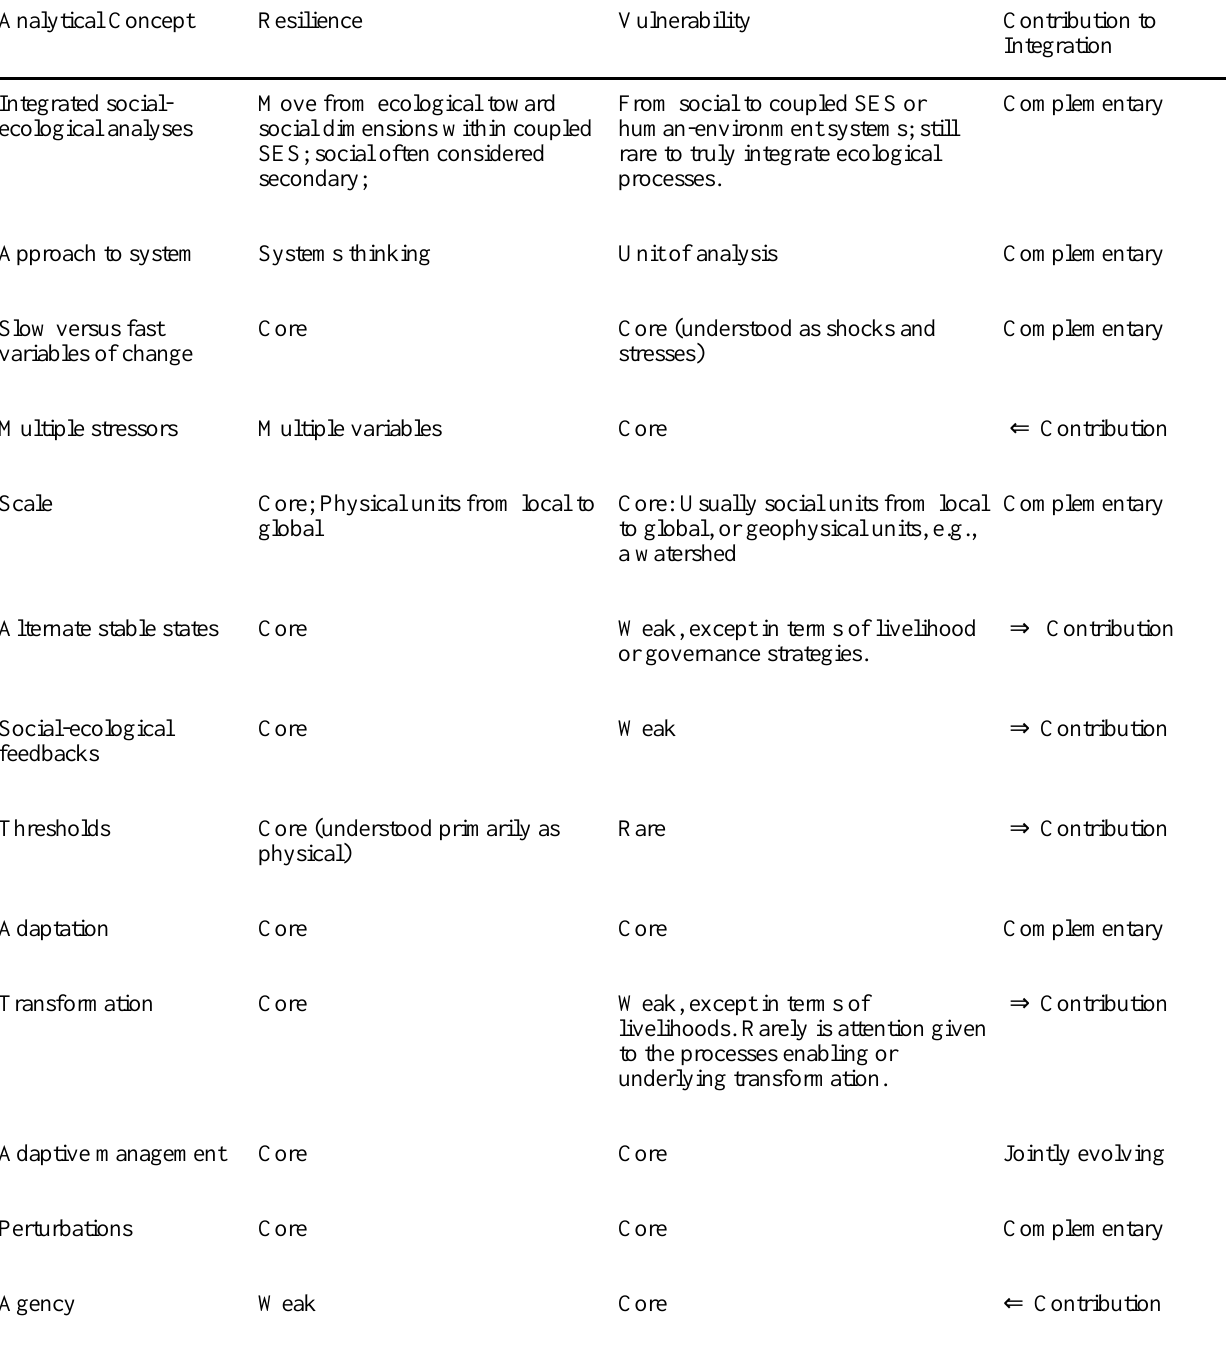
Table 1. Conceptual contributions and areas of convergence between resilience and vulnerability theory. SES = social-ecological